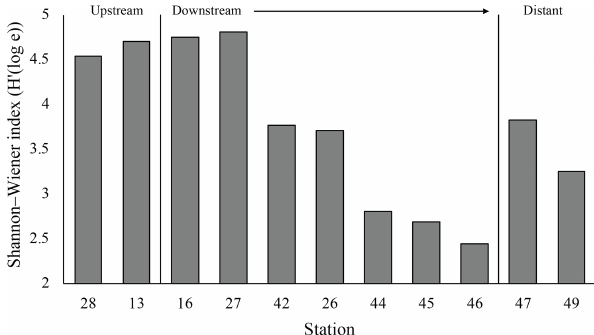
Figure 10. Mean Shannon–Wiener diversity index for microorgan- isms in each biotope. Error bars represent ± SE. Figure 11. Shannon–Wiener index values for microorganisms in each plume sample